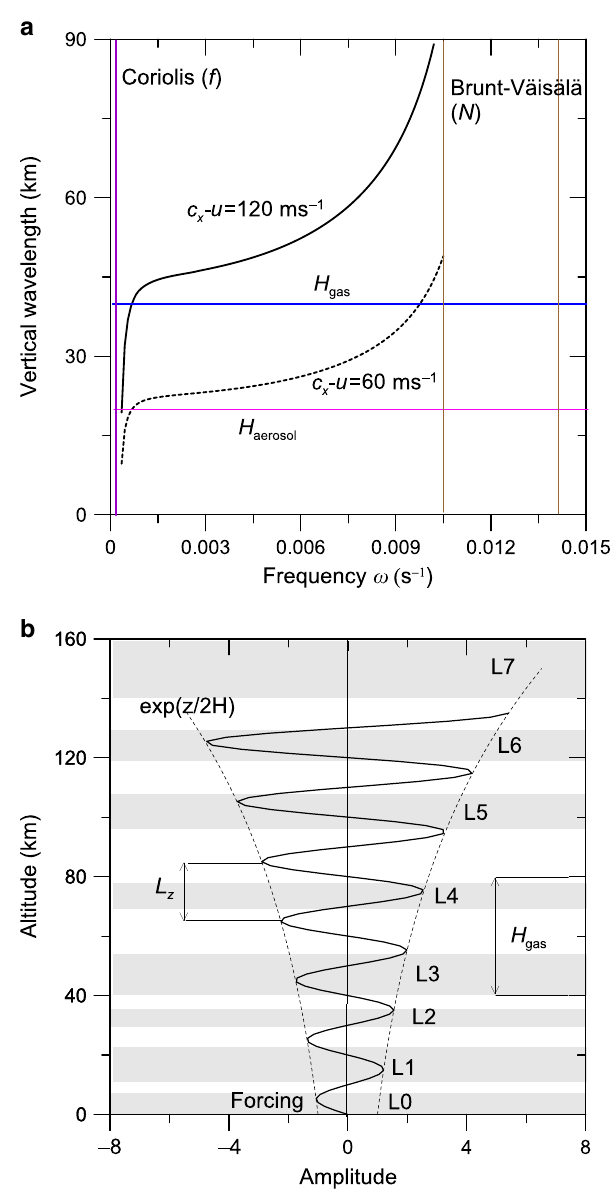
Fig. 5 Gravity waves and haze layers. a Vertical wavelength as a function of frequency. The frequency range is between Coriolis f (violet line) and Brunt – Väisälä frequency N = 0.012s − 1 (brown line) with a range of measured values N = 0.01 – 0.015 s − 1 taken from ref. 13 . Two cases are shown for values of the intrinsic velocity given by ( c x − u ) = 60 ms − 1 (dashed line) and 120 ms − 1 (continuous line) 5,6,13 . The mean-scale height of the atmosphere ( 〈 H gas 〉 = 40 km) and the average aerosol-scale height ( 〈 H aerosol 〉 = 20 km) as derived from the radiative transfer model calculations are also indicated. b Idealized amplitude oscillations for the gravity wave model assuming a mean vertical wavelength L z = 20 km and H = 40 km, and no dissipation. The altitude location and thickness of the gas observed haze layers are also indicated for comparison as given in Table